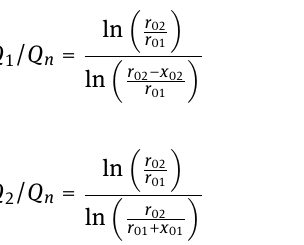
It can be seen that the smaller relative leakage was reached at constant internal radius r 01 (means in case 1) than in situation where external radius r 02 was constant.